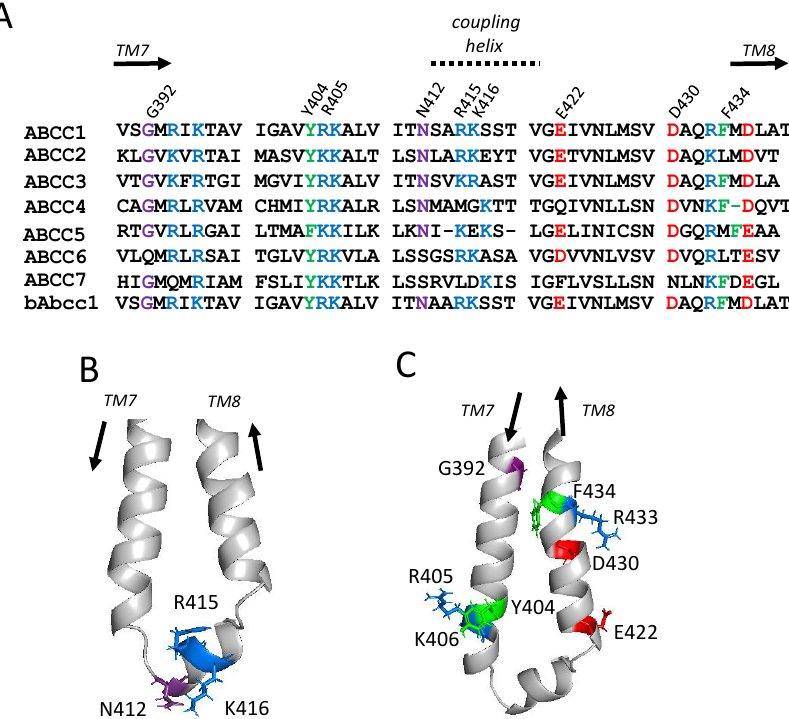
Figure 2. Sequence alignments of hMRP1 CL4 and location of residues targeted for mutagenesis. ( A ) Shown is a sequence alignment of CL4 of hMRP1/ABCC1 with the corresponding region of six of its human homologs (ABCC2–7) and bMrp1/Abcc1 generated using Clustal Omega [26]. The basic (Arg 405 , Arg 415 , Lys 416 ), acidic (Glu 422 ) and aromatic (Tyr 404 , Phe 434 ) amino acids targeted in the present study are highlighted in blue, red, and green, respectively, as are the corresponding residues (if conserved) in human ABCC2–7 and bMrp1/Abcc1. The targeted Gly 392 and Asn 412 are also highlighted (in purple) are the targeted Gly 392 and Asn 412 . Basic (Arg 394 , Lys 396 , Lys 406 , Arg 433 ) and acidic (Asp 430 , Asp 436 ) hMRP1 CL4 residues mutated in previous studies [19,22,23] are also highlighted in blue and red, respectively. ( B , C ) Shown are the locations of the targeted residues within a selected view of a 3-dimensional atomic homology model of hMRP1-CL4 [12] with their side chains shown in stick form and colored as in ( A ); ( B ) Asn 412 , Arg 415 and Lys 416 in the coupling helix of CL4; ( C ) Gly 392 , Tyr 404 , Arg 405 , Lys 406 , Glu 422 , Asp 430 , Arg 433 , and Phe 434 outside (‘flanking’) the coupling